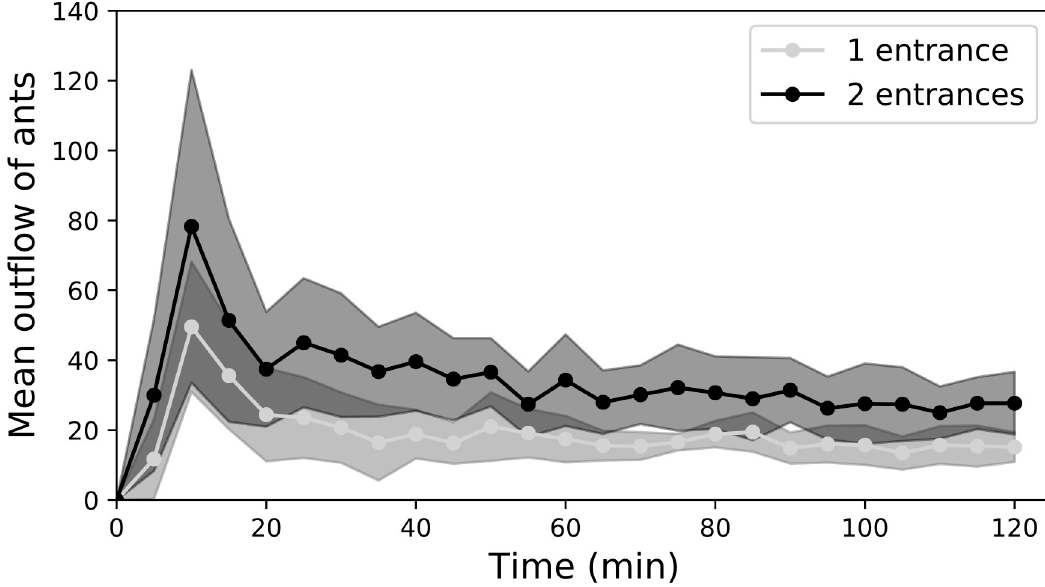
Fig 2. Dynamics of ants’ mobilisation out of a one-entrance or a two-entrance nest. Flows of ants outgoing from one-entrance nests and two-entrances nests are represented every 5 min in grey and black respectively. Circles and shadings represent the mean ± SD, respectively ( n =